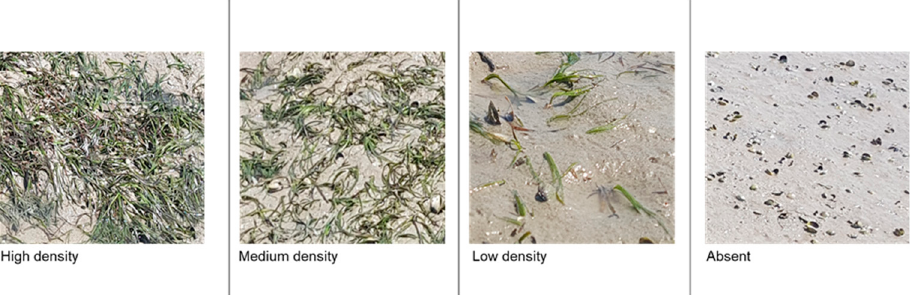
Figure 3. The classification schema to map seagrass density and distribution across the study area. Seagrass density on the ground is referred to absent as 0%, low as 1–40%, medium as 40–70% and high density as 70–100%. Seagrass images courtesy of Kavita Prasad.